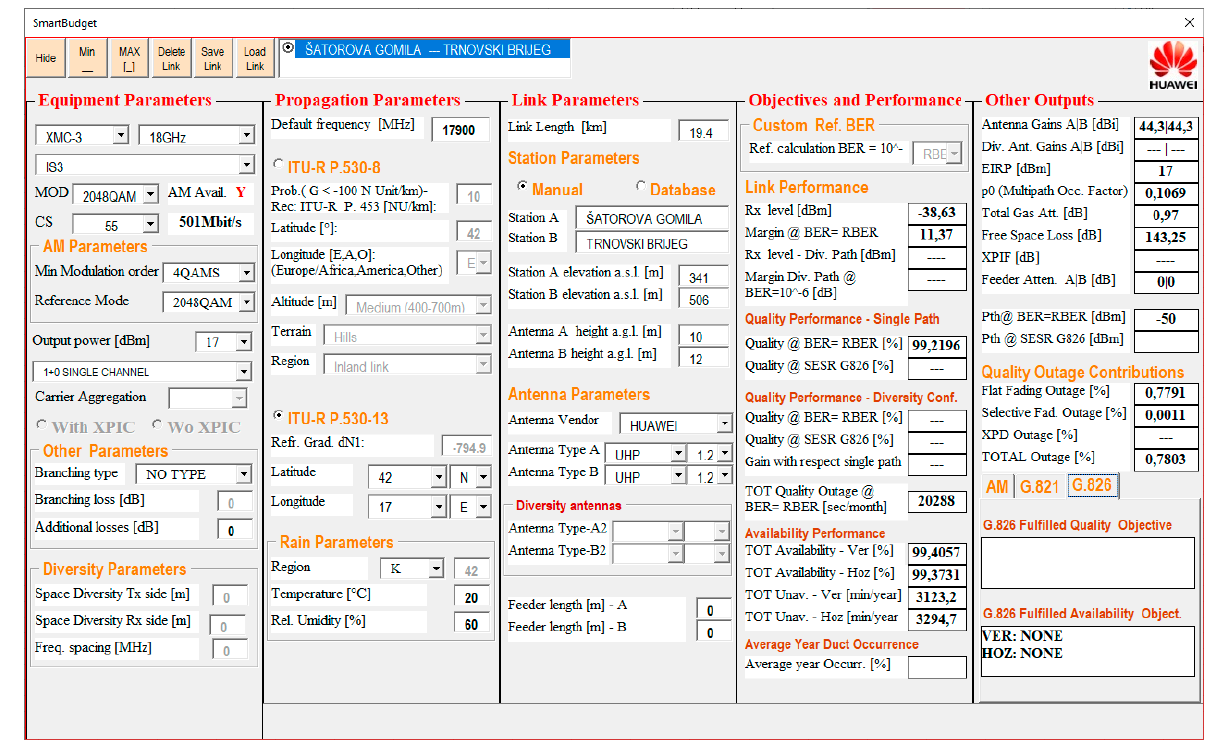
Figure 6. Prediction for the first RR section; 2048 QAM, 500 Mb/s.